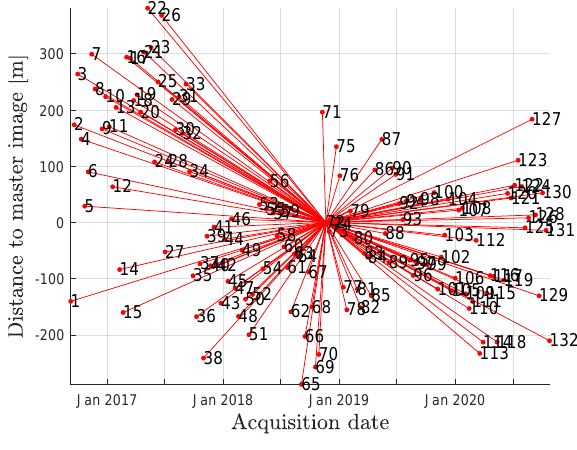
Figure 1. Temporal and spatial baselines, relative to the master image from 20th November 2018. The 132 images were acquired between 8th September 2016 and 24th October 2020, with a repeat interval of 11 days.